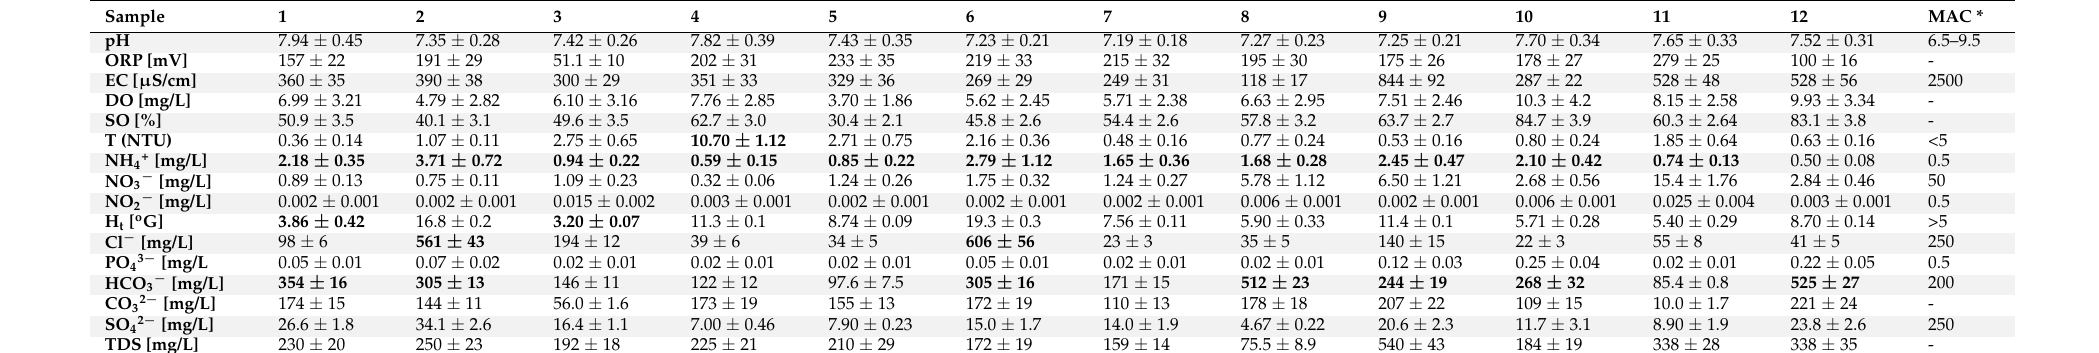
Table 1. Quality index parameters (mean ± standard deviation) of the groundwater samples